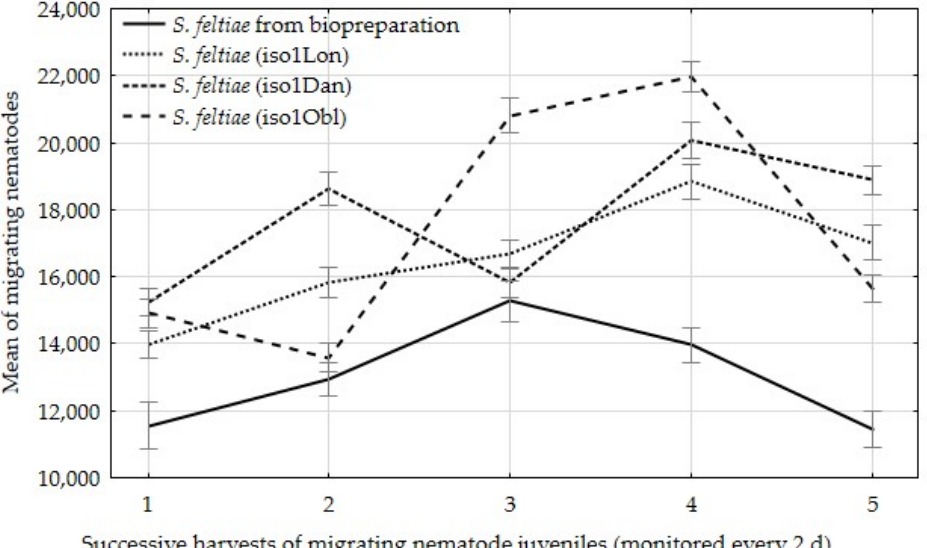
Figure 3. Mean of nematode juveniles migrating from one insect at successive harvests at 2-day intervals, ± standard deviation (SD).